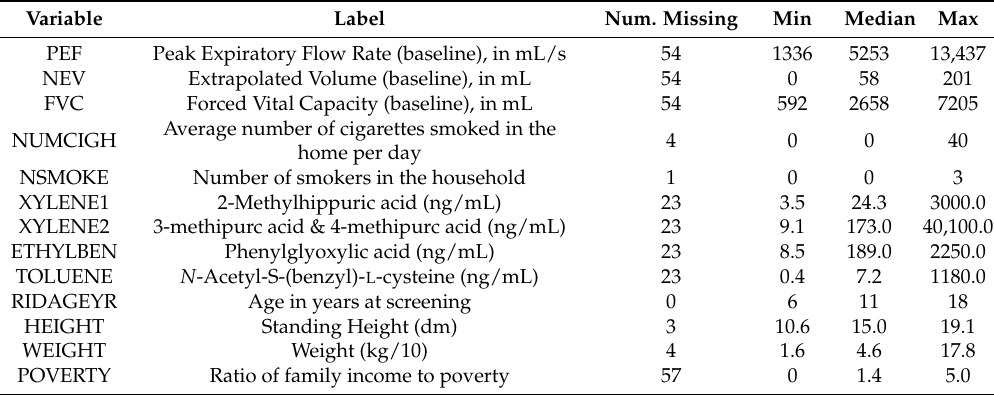
Table 1. Initial distribution of 2011–2012 National Health and Nutritional Examination Surveys (NHANES) variables among youth receiving the volatile organic compound (VOC) supplement (n = 748).